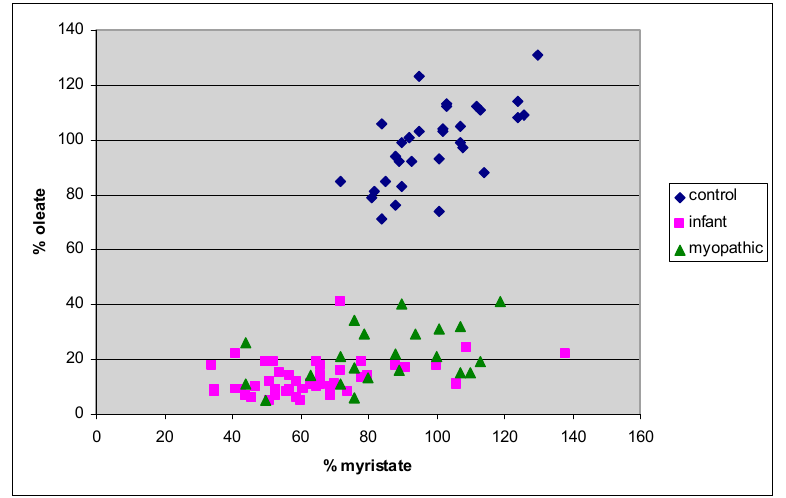
Figure 1. VLCADD percentage activity vs. oleate FAO-flux percentage activity at 37 °C. Results of flux assays at 37 °C show clear separation of all VLCADD cell lines from controls by plotting percentage oleate FAO-flux against percentage myristate FAO-flux (Figure 2). A degree of separation between infantile and myopathic phenotypes is clearly discernible, although there is some overlap between the two groups.